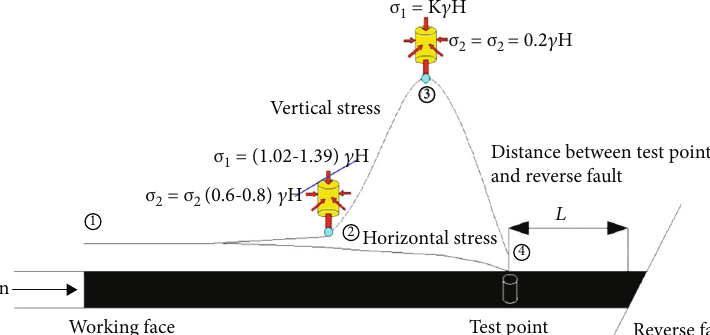
Figure 1: Stress variation of coal with a reverse